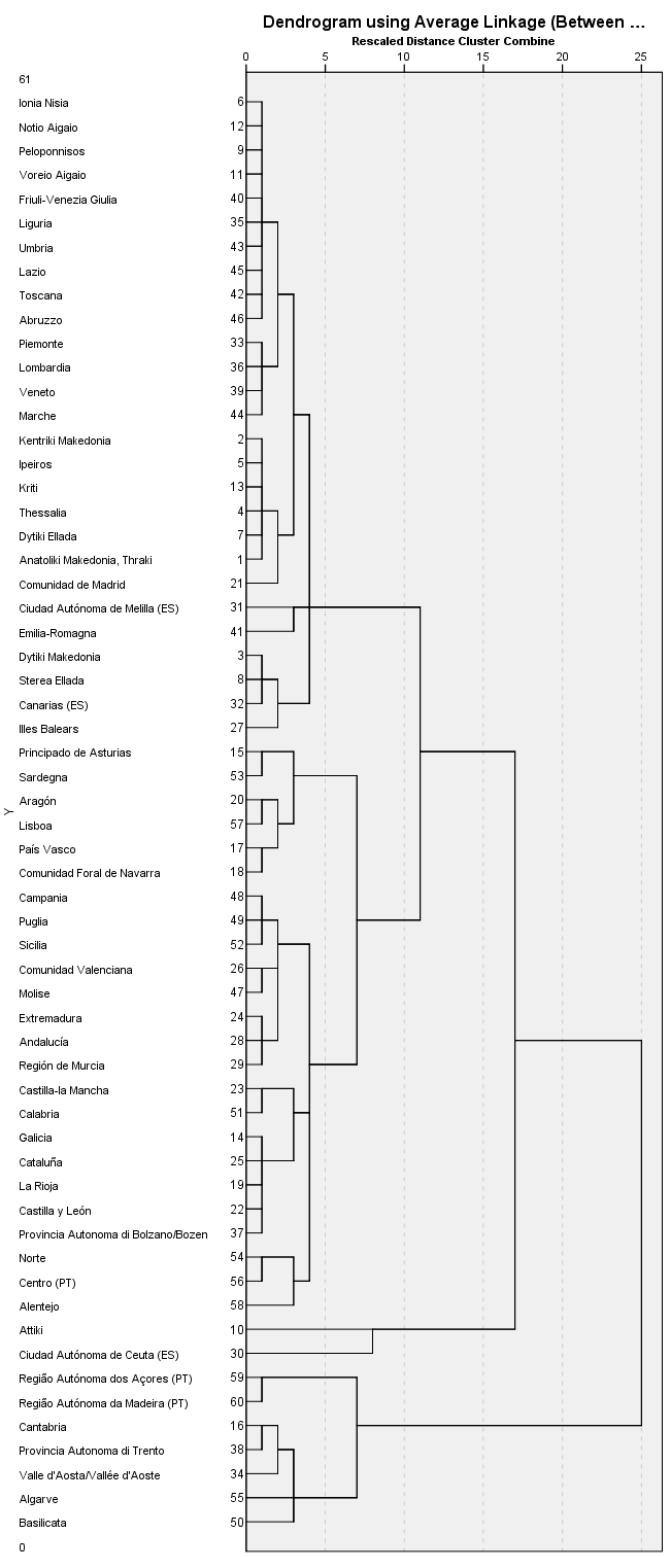
Figure A.4: Dendrogram based on the social characteristics of the south European regions